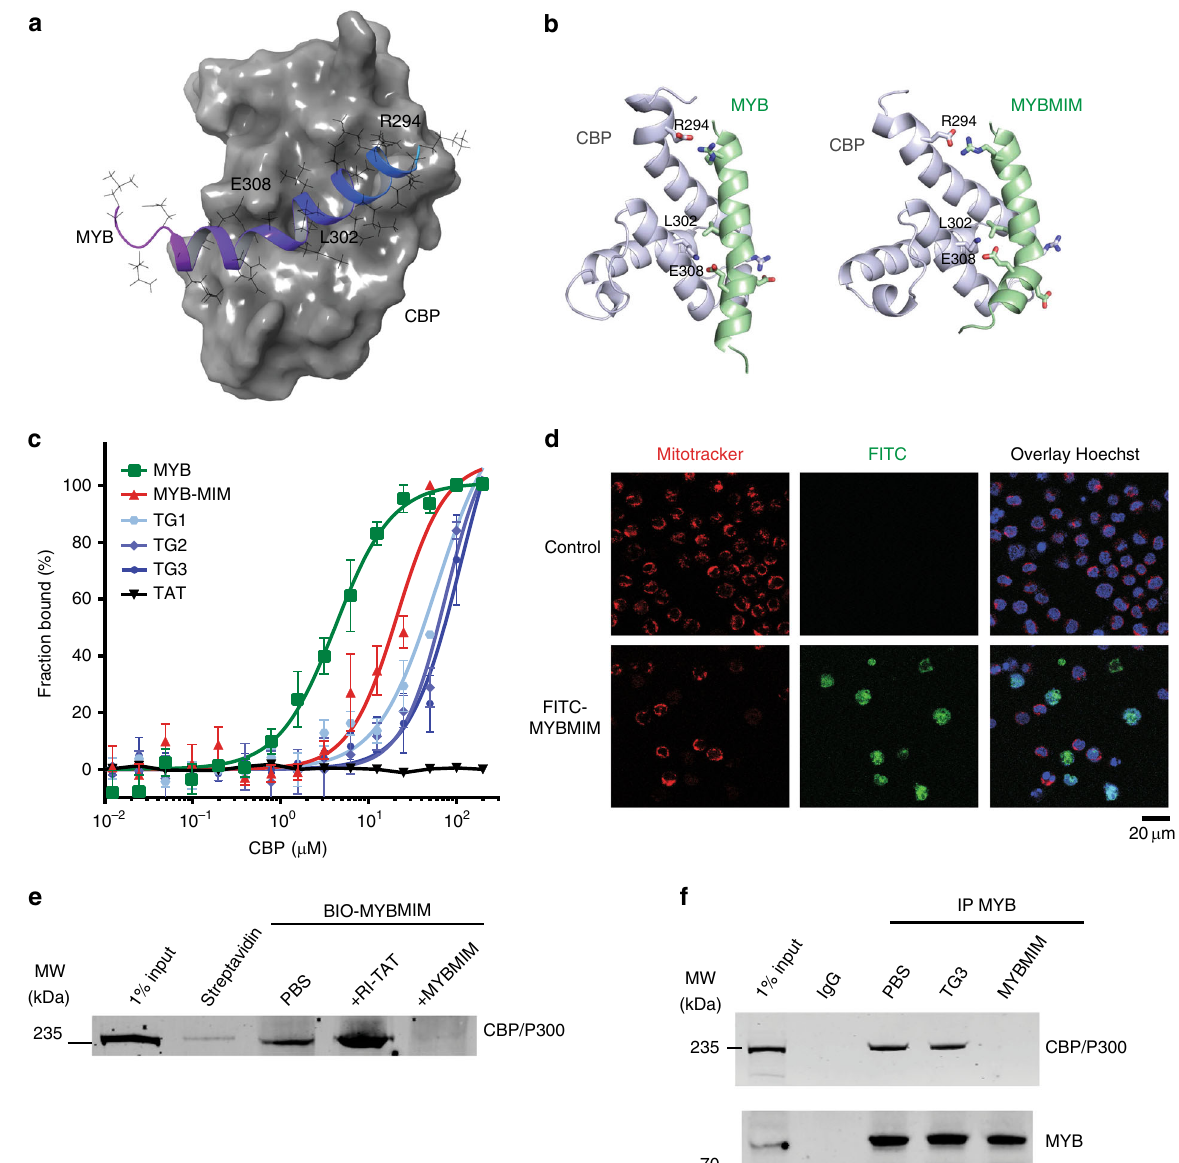
Fig. 1 MYBMIM disrupts the MYB:CBP complex in AML cells. a Molecular structure of the complex of the transactivation domain of MYB (blue) with the KIX domain of CBP (gray) 23 assembled in Maestro (Schrödinger). MYB residues making contacts with CBP are labeled as indicated. (PDB: 1SB0). b Molecular structures of the transactivation domain of MYB (left, green) and MYBMIM (right) in complex the KIX domain of CBP (gray), as modeled using replica exchange molecular dynamics. Both MYBMIM and MYB retain E308 and R294 salt bridge and L302 hydrophobic interactions, as marked by sidechain representation. c Binding of FITC-conjugated MYB (green), MYBMIM (red), compared to control TG1, TG2, TG3, and TAT (black), as measured using microscale thermophoresis ( K d = 4.2 ± 0.5 µ M and 21.3 ± 2.9 µ M for MYB and MYBMIM, respectively, 59.2 ± 12.4 µ M for TG1, 75.1 ± 12.5 µ M for TG2 and 113.5 ± 36.6 µ M for TG3). Error bars represent standard error mean of three biological replicates. d Live cell confocal fl uorescence microscopy photographs of MV-411 cells treated with 50 nM FITC-MYBMIM (green) for 1 h, as visualized using Mitotracker (red) and Hoechst 33342 (blue). Scale bar indicates 20 μ m, with z -stack of 1.5 μ m. e Western blot showing comparable binding of cellular CBP/P300 to streptavidin bead-immobilized BIO- MYBMIM, speci fi cally competed by 20-fold excess free retro-inverso TAT (RI-TAT) and MYBMIM peptides, as indicated by + signs. f Representative western blot of MYB:CBP/P300 complex immunoprecipitated from MV411 cells disrupted 20 μ M MYBMIM and TG3, as MYBMIM suppresses transcriptional enhancers and activation (Fig. 1f). We found that MYBMIM competition led to signi fi cant in AML cells . MYB and CBP/P300 mediate their transcriptional dissociation of the cellular MYB:CBP/P300 complex, as compared to untreated or control treated complexes (Fig. 1f), co-activation effects in part through the assembly and stabiliza- consistent with the competitive binding af fi nities of the tion of transcription factor complexes at speci fi c enhancers and retro-inverso MYBMIM and native MYB peptides to the CBP promoter elements 33,34 . Thus, dissociation of the MYB:CBP/P300 complex by MYBMIM would be expected to reduce KIX domain in vitro (Fig. 1c). Thus, MYBMIM is a speci fi c MYB-dependent occupancy and gene trans-activation at speci fi c peptidomimetic inhibitor of MYB:CBP/P300 complex assembly target genes responsible for aberrant leukemia cell growth and in cells.